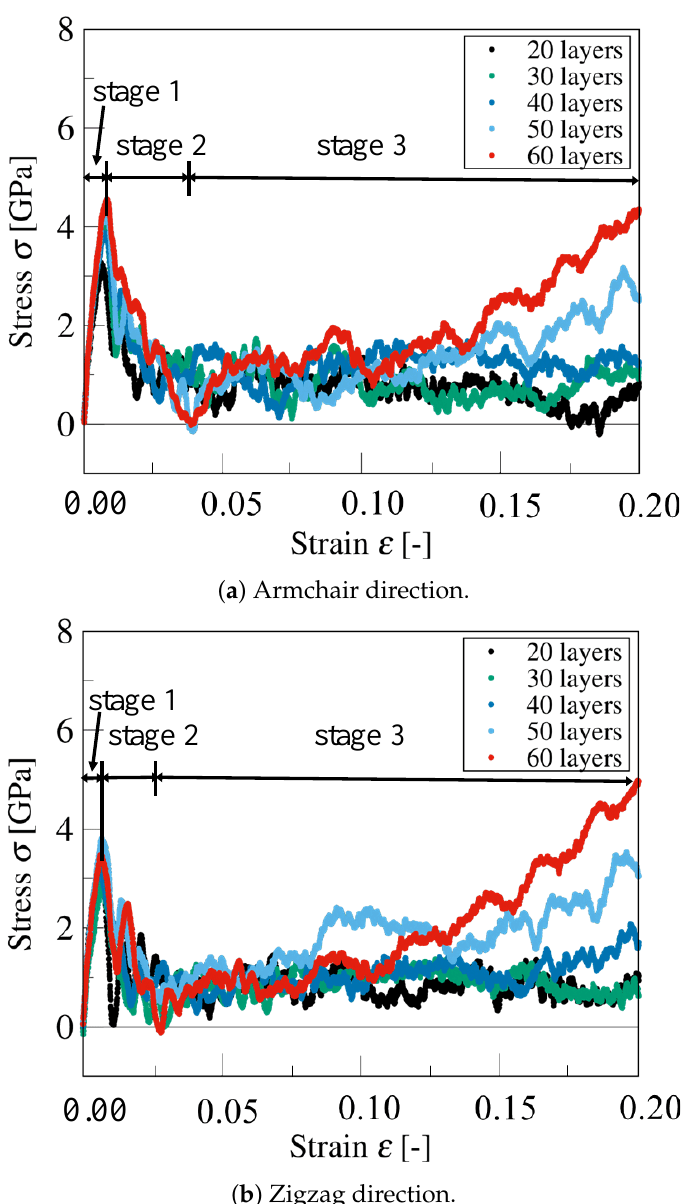
Figure 9. Compressive stress–strain curve of graphite. Figure 10a,b expresses the relationship between the potential energy per atom and the compressive strain in armchair and zigzag graphite with 20, 30, 40, 50, and 60 graphene layers, respectively. We could see that the potential energy per atom E p , in terms of armchair and zigzag graphite with different graphene layers, showed an increasing trend with the increase in compressive strain, where the number of layers and the chirality of graphite had less of an effect on the growth of the average potential energy. The curves were almost monotonically increasing, but for part of them, the increasing ratios were not linear; we speculated that this was because of the appearance of out-of-plane deformation, kink deformation, and delamination in the compressed